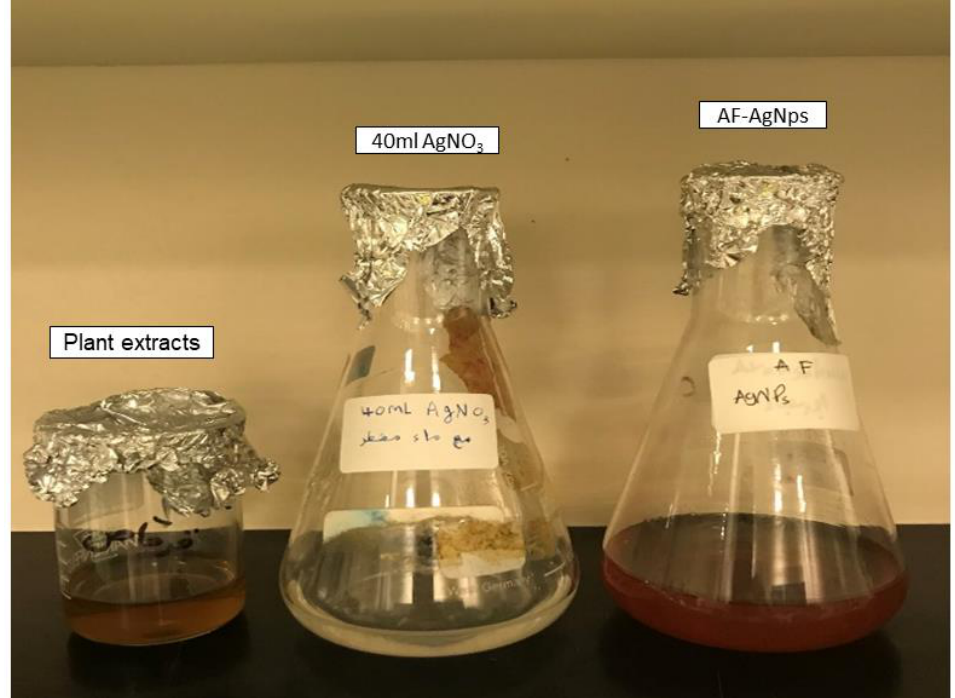
Figure 1. The color change in the silver nanoparticles biosynthesis. The leaves of A. factorovskyi were cut, rinsed, and boiled for 15 min, AgNO 3 was diluted in distilled water to produce a clear solution that was mixed later with the A. factorovskyi plant extract. The mixture was subjected to sunlight for 30 min. The color changed after incubation to reddish brown.